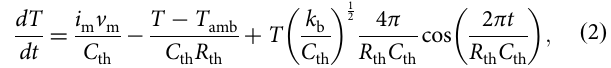
top Pt electrode. Figure 2e shows the 20 consecutive switching curves under the sinusoidal voltage wave application. From point ① to ② , heat was generated in the NbO 2 . Then, the heat ran away along the Nb 2 O 5 – x fi lament while accelerating the thermally activated conduction in the NbO 2 until point ③ . Afterward, from point ③ to ④ , the heat dissipated, and the device returned to point ① . Figure 2f shows the temperatures at point ② (red) and point ④ (blue) for each simulation cycle. The variation in switching temperature con fi rms that the residual heat was not a fi xed value during the device oscillation. More detailed thermodynamic simulation results can be found in Supplementary Fig. S2.